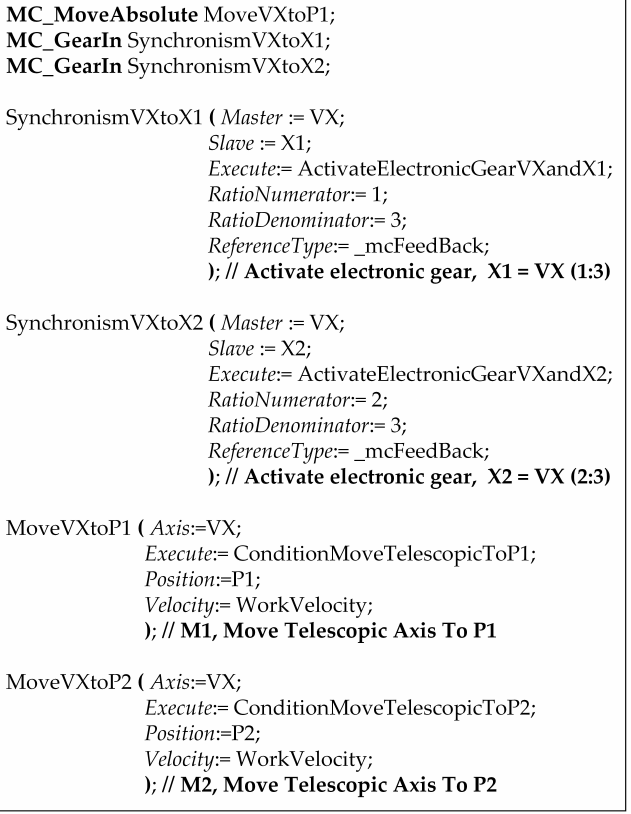
Figure 20. Program in PLCopen to position the telescopic axis tool with master virtual servo axis.